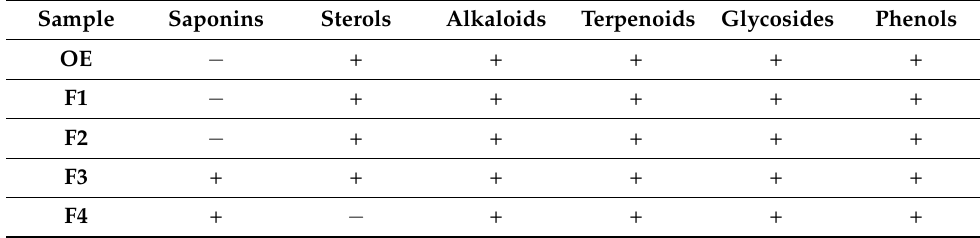
Table 2. Qualitative chemical screening of OE and F1 – F4 obtained from E . cavolini . Sample